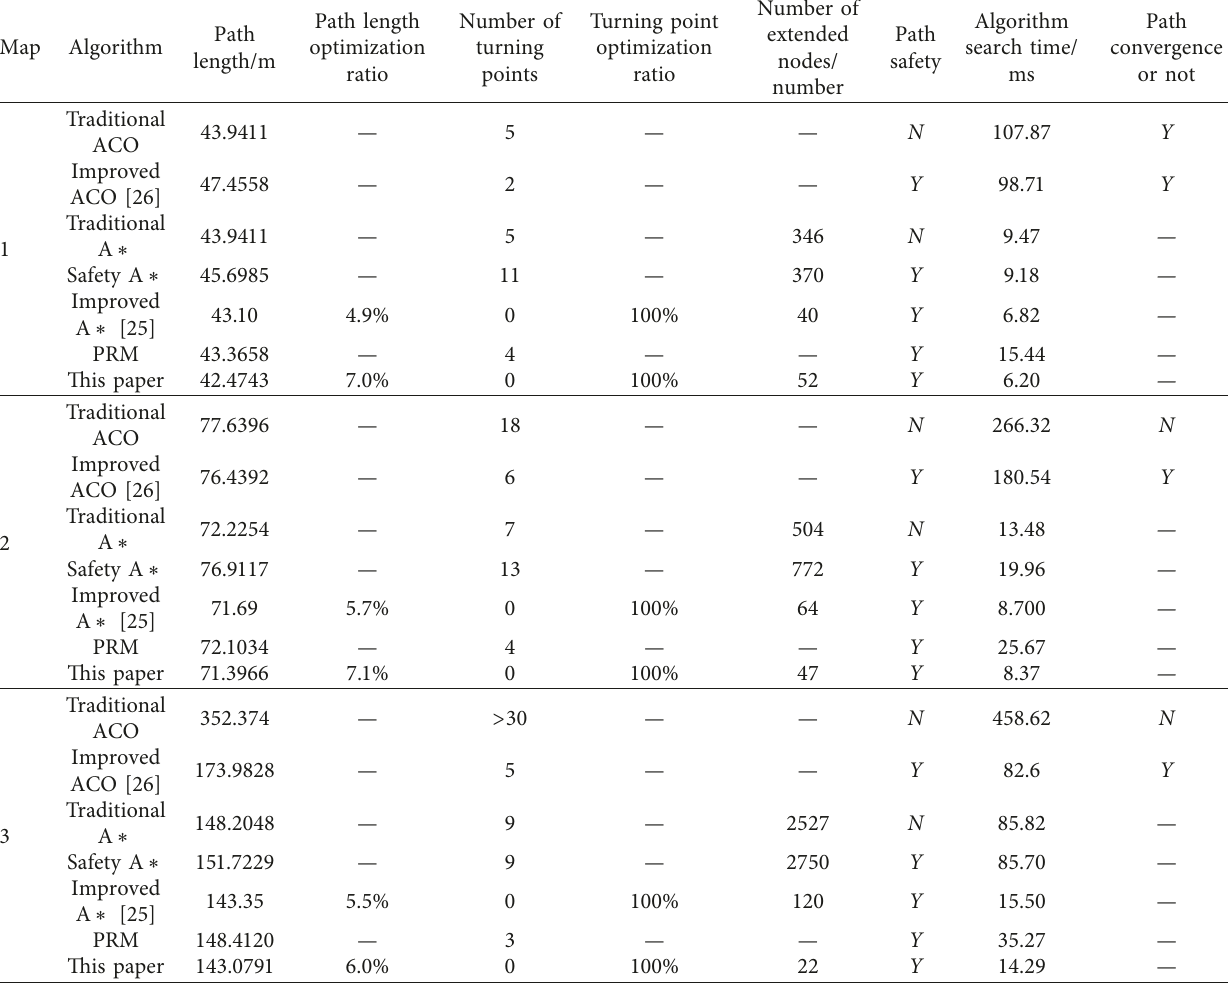
Table 1: Three sets of static map simulation data.